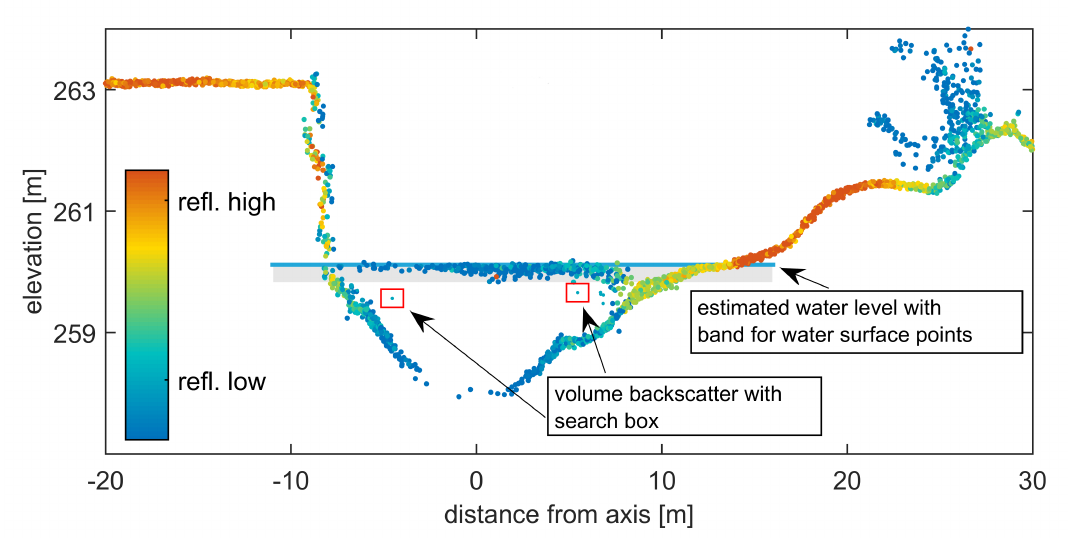
Figure 5. Classification of water echoes based on echo reflectance, distance from water surface and spatial distribution; principal